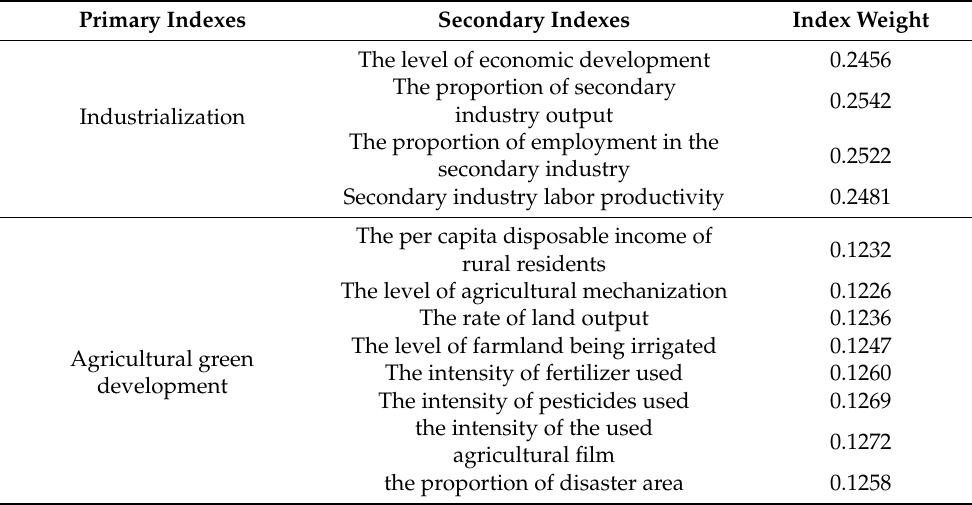
Table 2. Evaluation index weights of the coupling coordination degree of industrialization and agricultural green